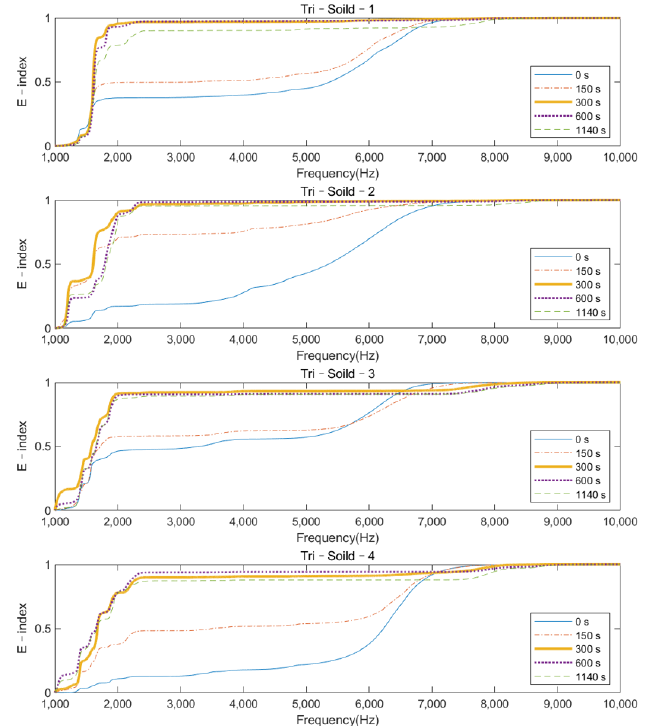
Figure 11. E–index as the function of frequency at five different times (0, 150, 300, 600, and 1140 s) for a solid IM stem condition.